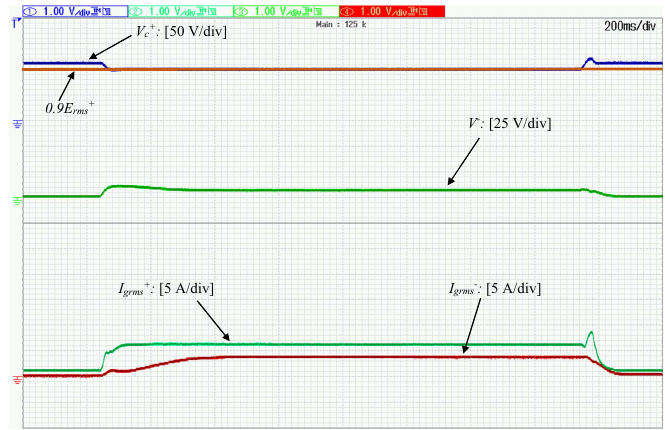
Figure 8. Operation under two-phase voltage drop ( V ga = 0.73p.u. and V gc = 0.65p.u.): Positive and negative sequence RMS voltages and